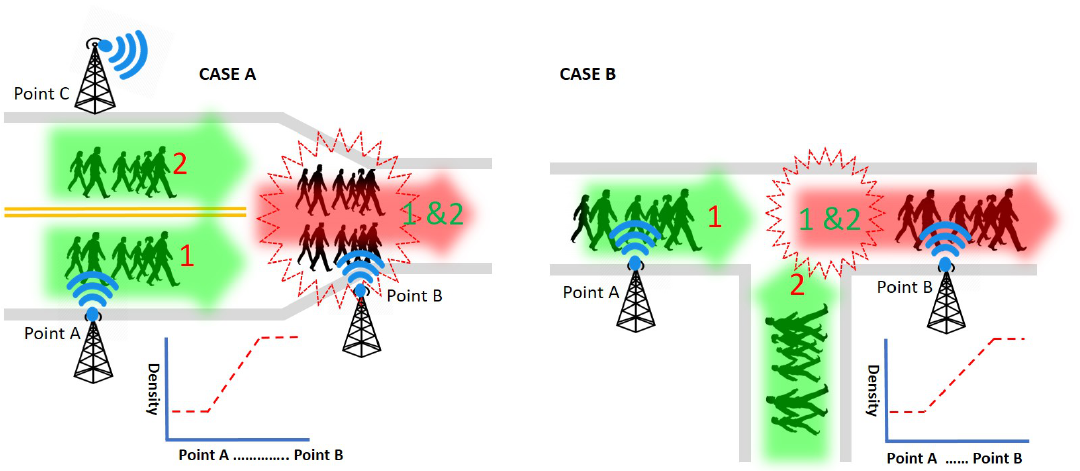
Figure 9. Lane merge detection via